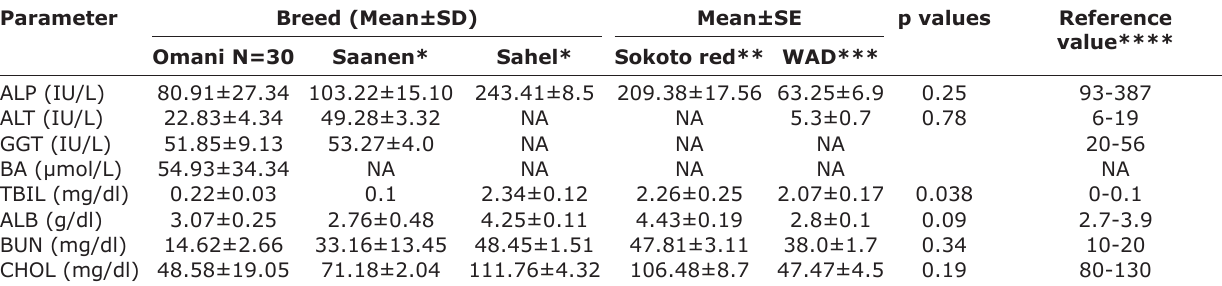
Table-2: Serum biochemistry values of different goat breeds were compared together.